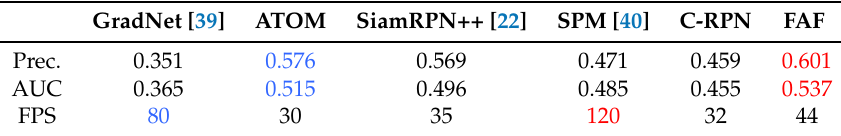
Table 6. Comparison with state-of-the-art trackers on the LaSOT dataset. The results are presented in terms of precision and AUC. The best and second results are in red and blue,